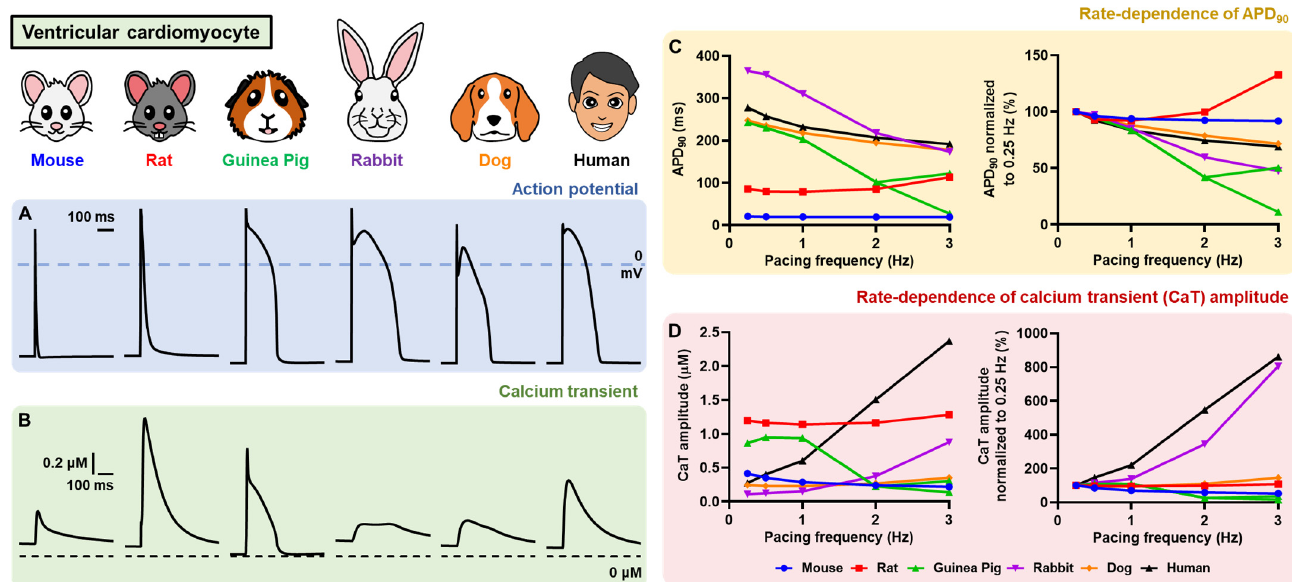
Figure 4. Interspecies difference of AP and calcium transient (CaT) in several computational models of ventricular cardiomyocytes. All simulations were carried out in Myokit [31]. ( A , B ) The AP and CaT were stimulated using the default setting of each model at a 1 Hz pacing frequency (basic cycle length [BCL] of 1000 ms) and quasi-steady-state was obtained following 1000 beats of pre-pacing. ( C , D ) The rate dependence of APD 90 and CaT. Mouse model = Bondarenko et al. (2004; [48]), Rat model = Niederer et al. (2007; [49]), Guinea-Pig model = Noble et al. (1998; [50]), Rabbit model = Mahajan et al. (2008; [51]), Dog model = Decker et al. (2009; [21]) and Human model = O’Hara et al. (epicardial; 2011; [52]). By default, the Bondarenko and Niederer models were set at room temperature (22–25 °C), whereas the rest of the models were set at body temperature (±37 °C).